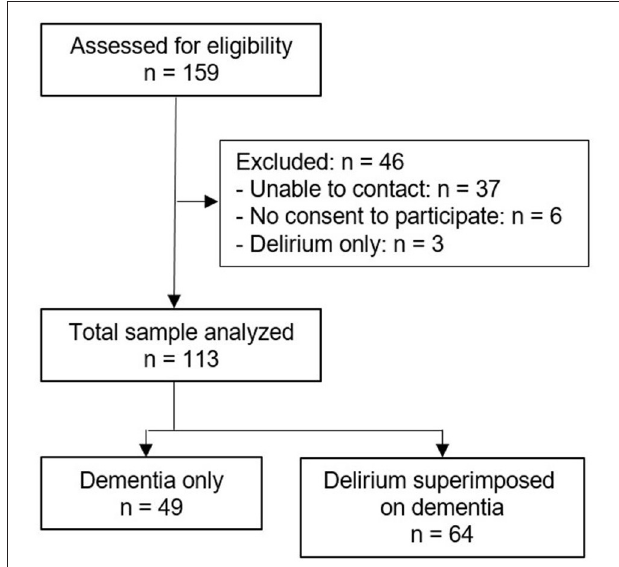
FIGURE 1 | Study flow